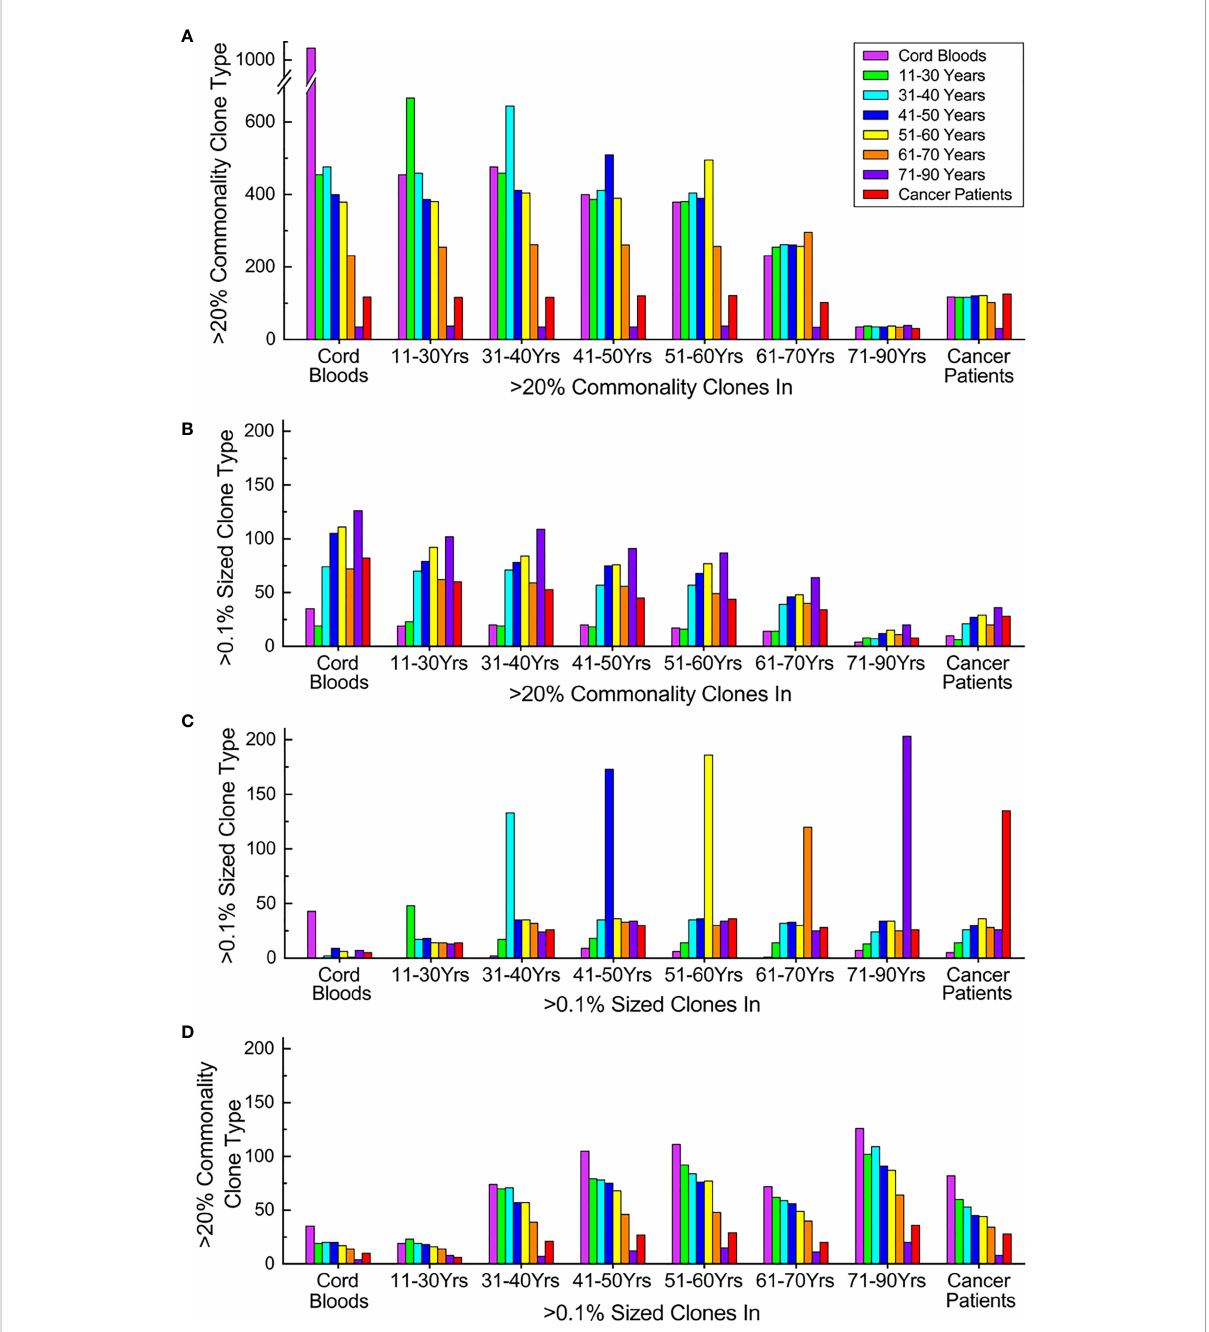
FIGURE 5 Expanding and losing commonality and transitions of TCR b clone characters upon aging and oncogenesis. (A) Commonality transitions of subgroup high-commonality TCR b clones (sgHCTCs). Each stack of columns represents sgHCTCs identi fi ed in a given subgroup, while each column in the stack indicates the number these sgHCTCs still as >20% commonality clones in different subgroups. (B) Expansion transitions of sgHCTCs. Each stack of columns represents sgHCTCs identi fi ed in a given subgroup, while each column in the stack indicates the number these sgHCTCs also as >0.1% sized expanding big clones in different subgroups. (C) Expansion transitions of expanding big clones. Each stack of columns represents expanding big clones identi fi ed in a given subgroup, while each column in the stack indicates the number these big clones still as >0.1% sized clones in different subgroups. (D) Commonality transitions of expanding big clones. Each stack of columns represents expanding big clones identi fi ed in a given subgroup, while each column in the stack indicates the number of these big clones also as >20% commonality clones in different subgroups. The column colors represent types of given characteristic clones in different subgroups: magenta: cord blood samples, green: 11 – 30 years old, cyan: 31 – 40 years old, blue: 41 – 50 years old, yellow: 51 – 60 years old, orange: 61 – 70 years old, violet: 71 – 90 years old, and red: cancer patients. All panels share the same color mapping. ns, not signi fi